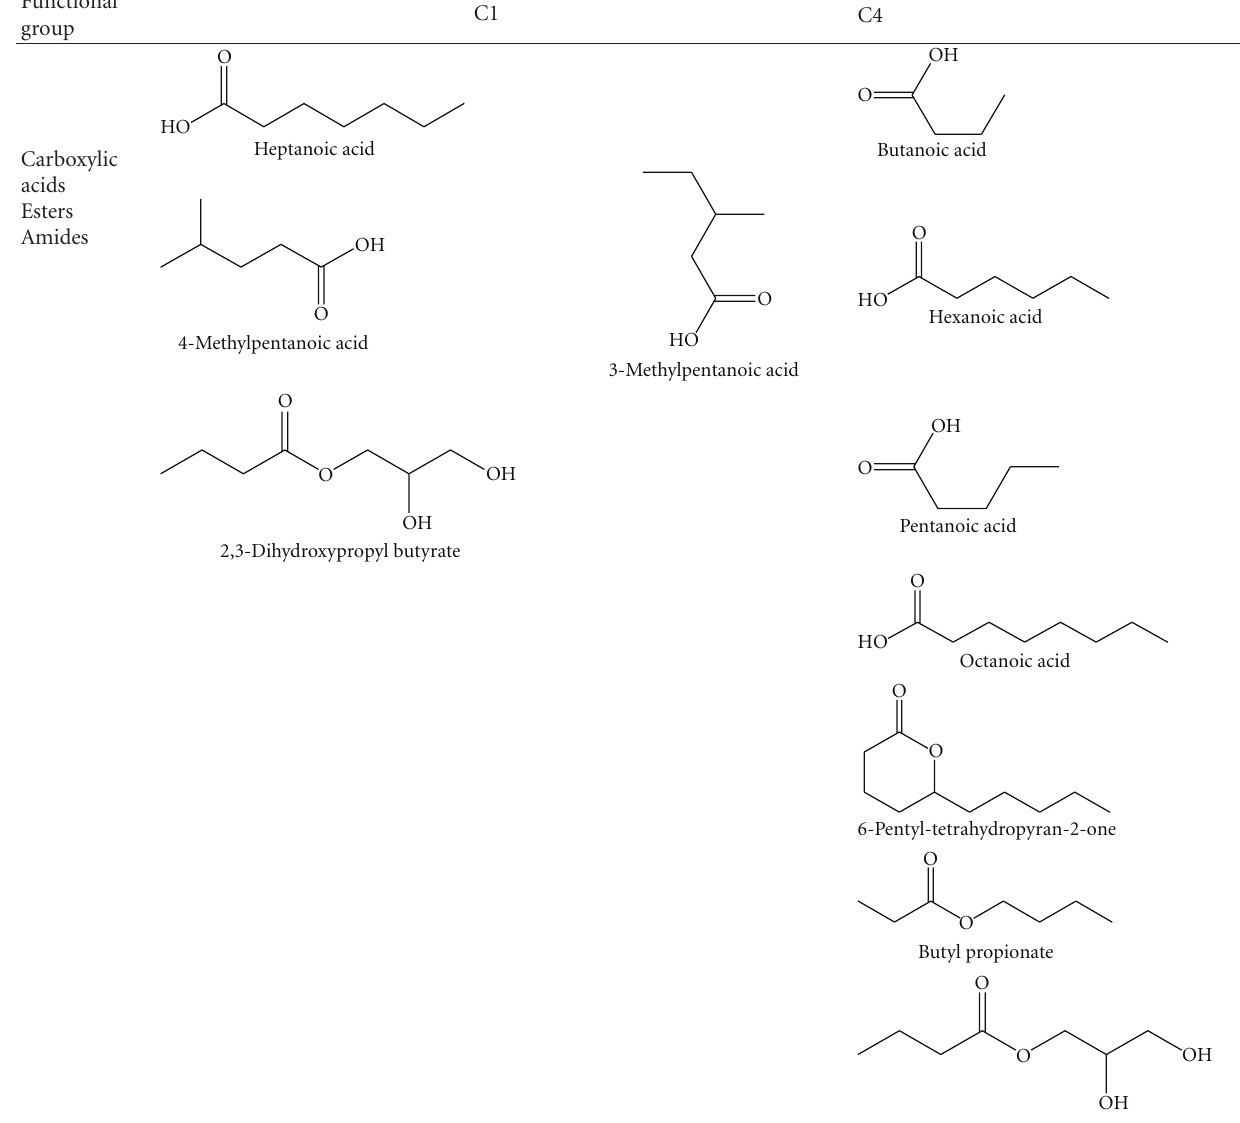
Table 4: Molecular composition of the low-molecular-weight fraction of the extracts from composts C1 and C4. Carboxylic acids, esters, and amides. Functional group